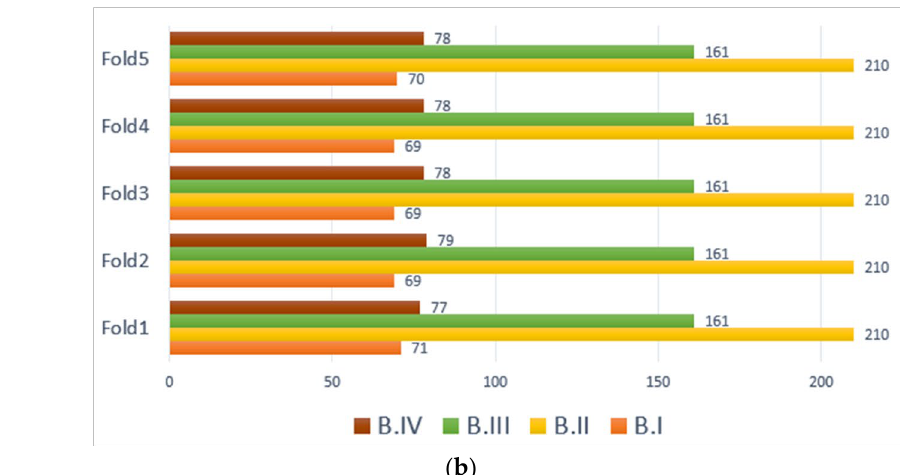
Figure 4. ( a ) Data distribution of the DDSM dataset over the four classes; ( b ) data distribution of the DDSM dataset for each fold. DDSM dataset for each